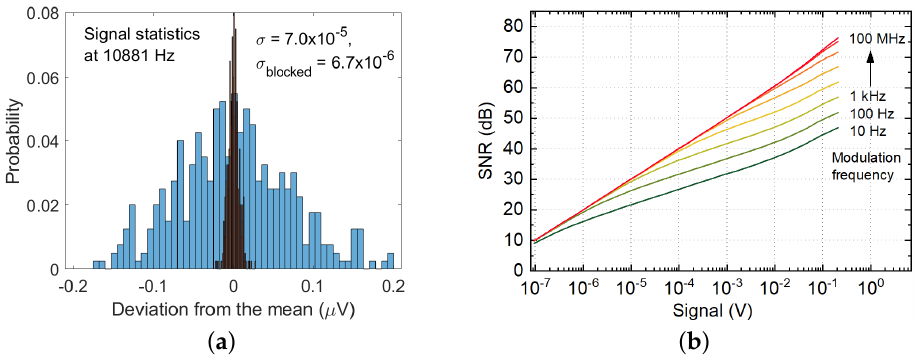
Figure 12. ( a ) Statistics of the detector output signal in two cases: in normal measurement mode (blue wider bars) and with a blocked source (black, narrower bars). ( b ) The modeled dependency of the detector SNR on the signal strength and modulation frequency at a carrier frequency of 250